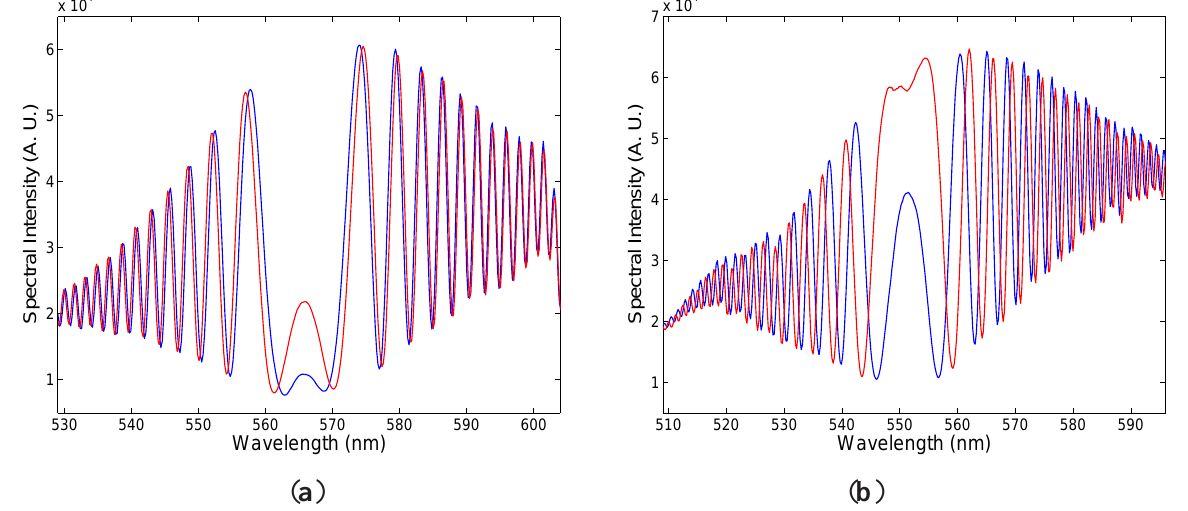
Two examples of the recorded spectra corresponding to two elongations ∆ L = 100 µ m (blue) and ∆ L = 300 µ m (red) of the fiber: x -polarized modes ( a ), 1 2 y-polarized modes ( b